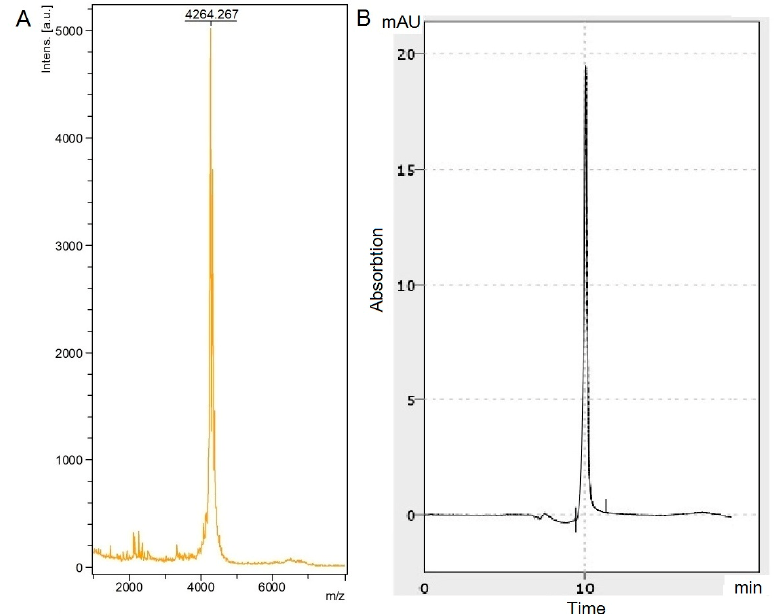
Figure 1. Mass spectrometry ( A ) and chromatogram ( B ) of mu-agatoxin-Aa1a